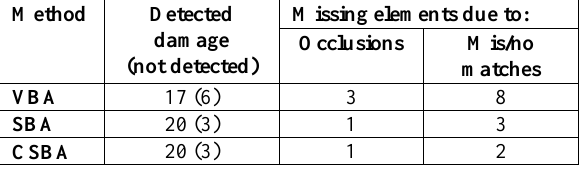
Table 1. The results of missing pre-event 3D segments detected by all three approaches.